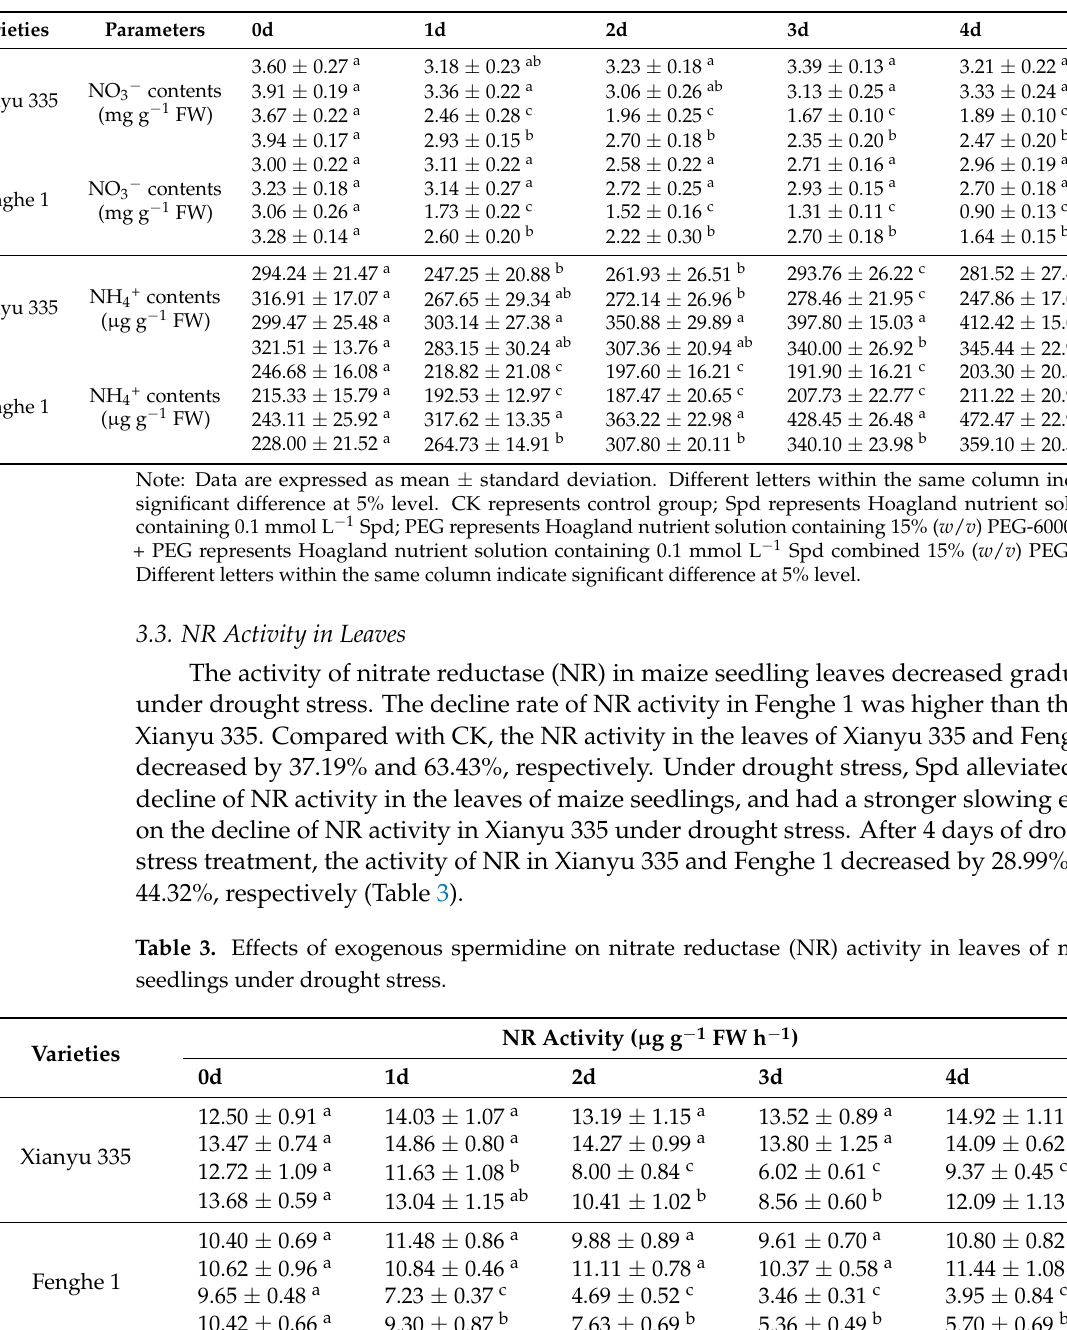
Table 2. Effects of exogenous spermidine on the content of NO 3 − and NH 4+ in leaves of maize seedlings under drought stress.